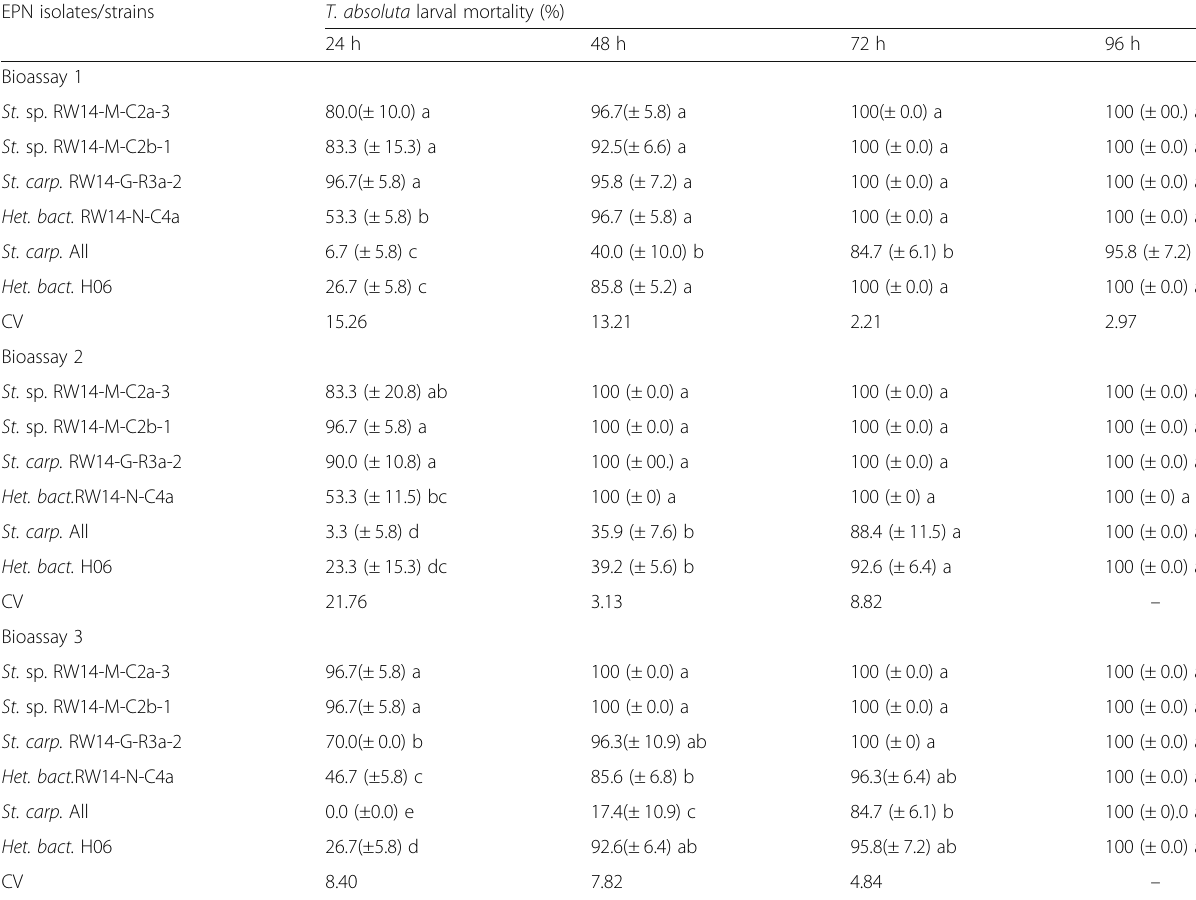
Table 2 Daily mortality of T. absoluta larvae (mean ± SD) in leaf galleries treated with local and exotics EPNs using the concentration of 500